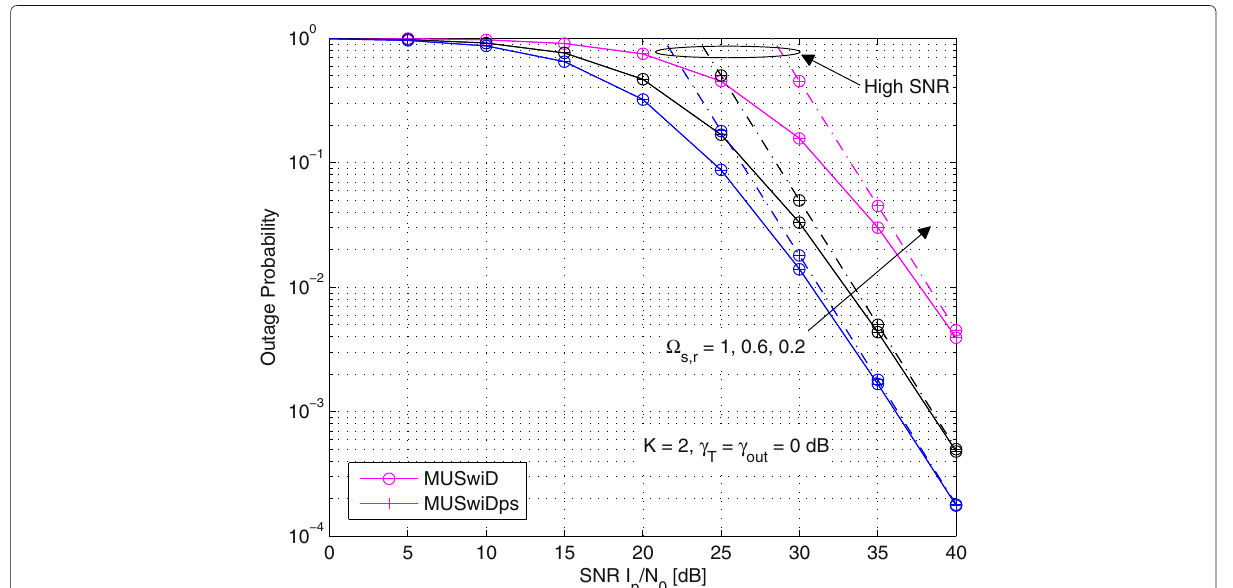
Fig. 4 Outage probability vs SNR of cognitive AF relay network with MUSwiD and MUSwiDps user selection schemes for different values of (cid:3) s,r and (cid:3) = 95, (cid:3) = 0.97, (cid:3) = 1 for k = 1,2 s,p r,p r, k